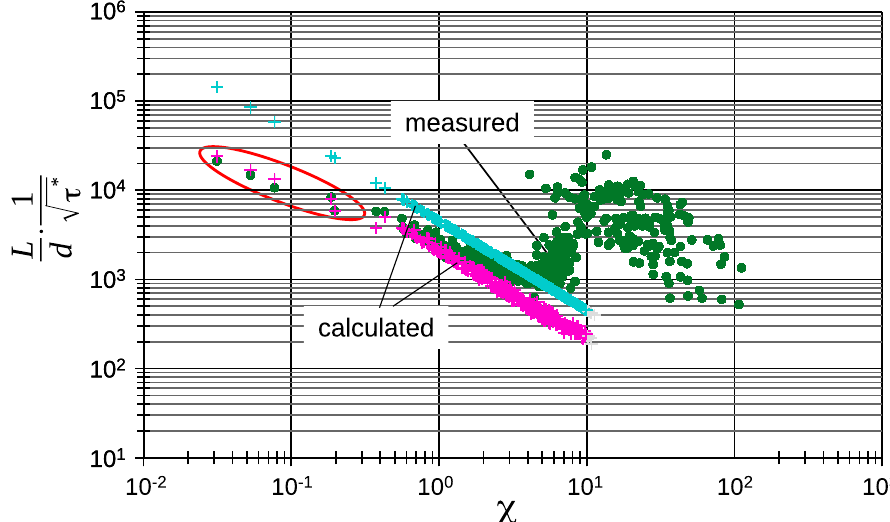
Figure 8. Comparison of the measured data (green), Equation (18) (blue) and Equation (22) (magenta). The difference of the two equations describes the individual effects of suspension (Note: In the range of χ > 9, according to Lapotre et al., 2017, bed forms are dunes.) For data source, see Section